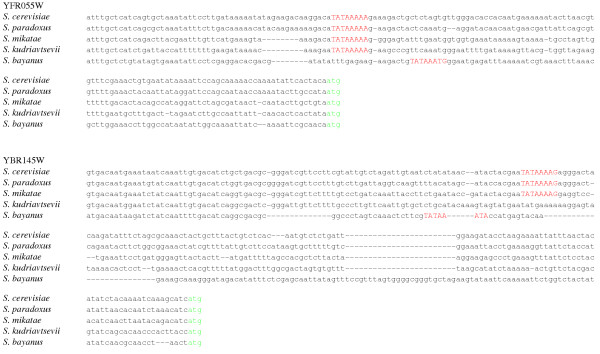
Genes with functional class 1 (TATA box-containing) promoters in S. cerevisiae in which TATA box shifted in one of the other species of sensu stricto group. Red, TATA consensus sequence; green, ATG start codon. In ORF YFR055W (hypothetical ORF), the distance in alignment between starts of TATA consensus sequences in S. cerevisiae and S. bayanus is 17 nucleotides. In ORF YBR145W (ADH5, alcohol dehydrogenase isoenzyme), the distance in alignment between starts of TATA consensus sequences in S. cerevisiae and S. bayanus is 19 nucleotides.